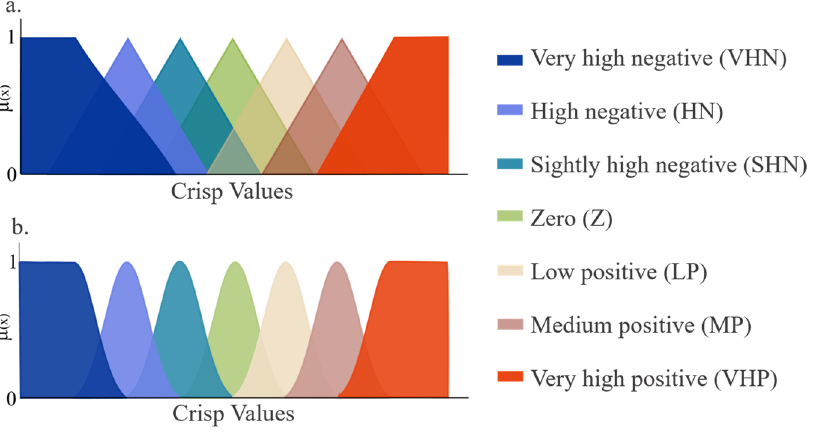
Figure 2. Membership function sets for the input and output variables. ( a ) trapezoidal functions; ( b ) Gaussian functions.